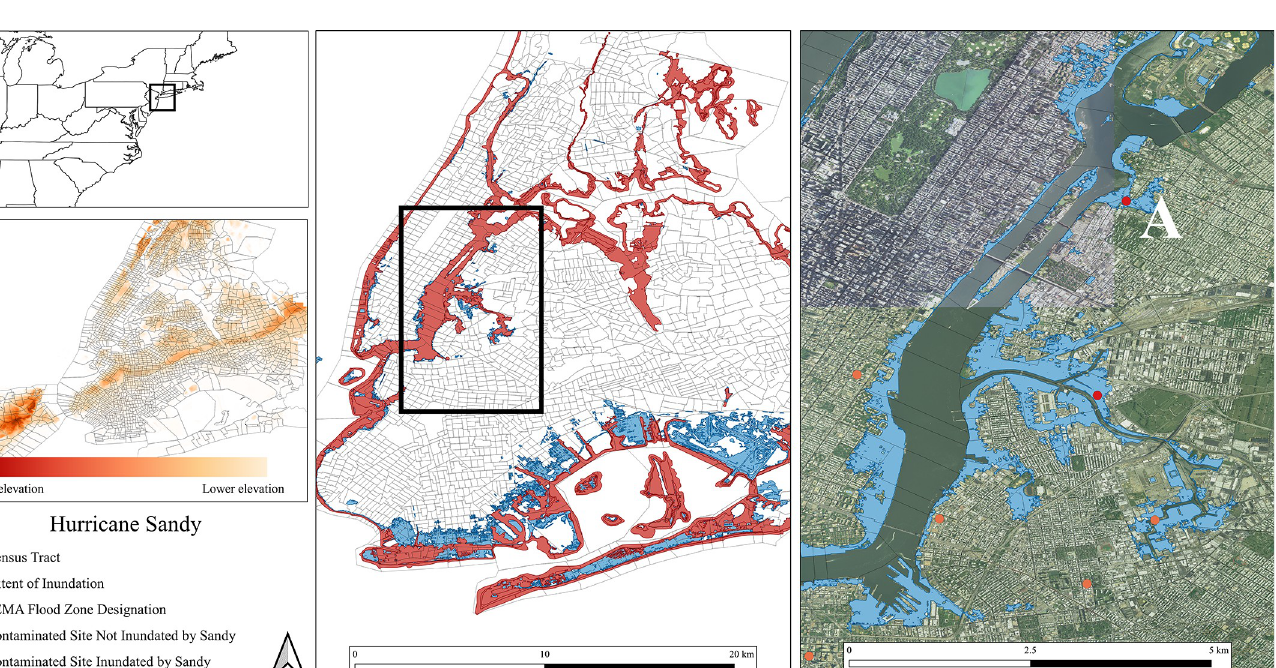
PLOS ONE | https://doi.org/10.1371/journal.pone.0226958 December23,